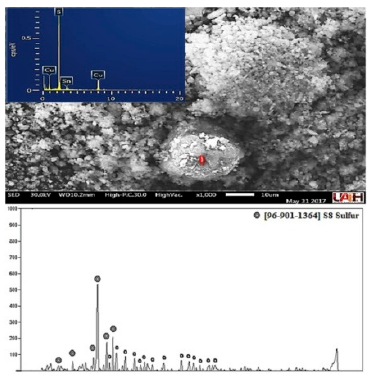
Figure 11. Solid residue image obtained after leaching of WEEE.